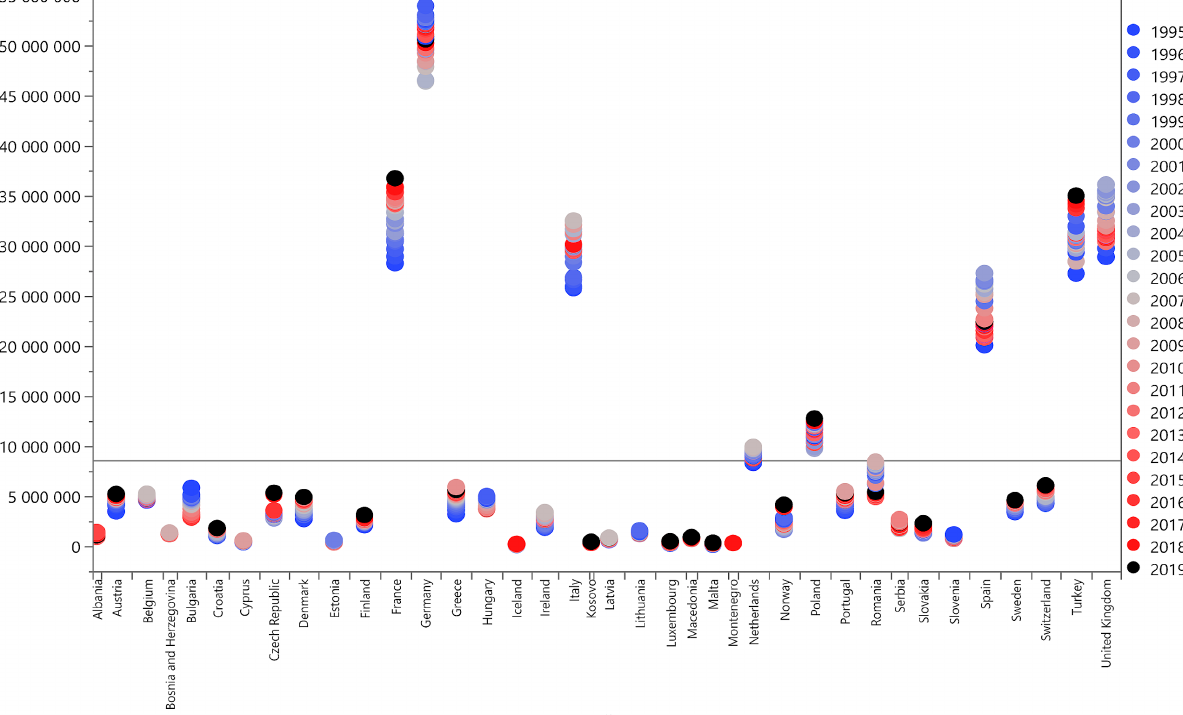
Figure 7. Municipal waste generation in the EU 1995–2019 in tons.